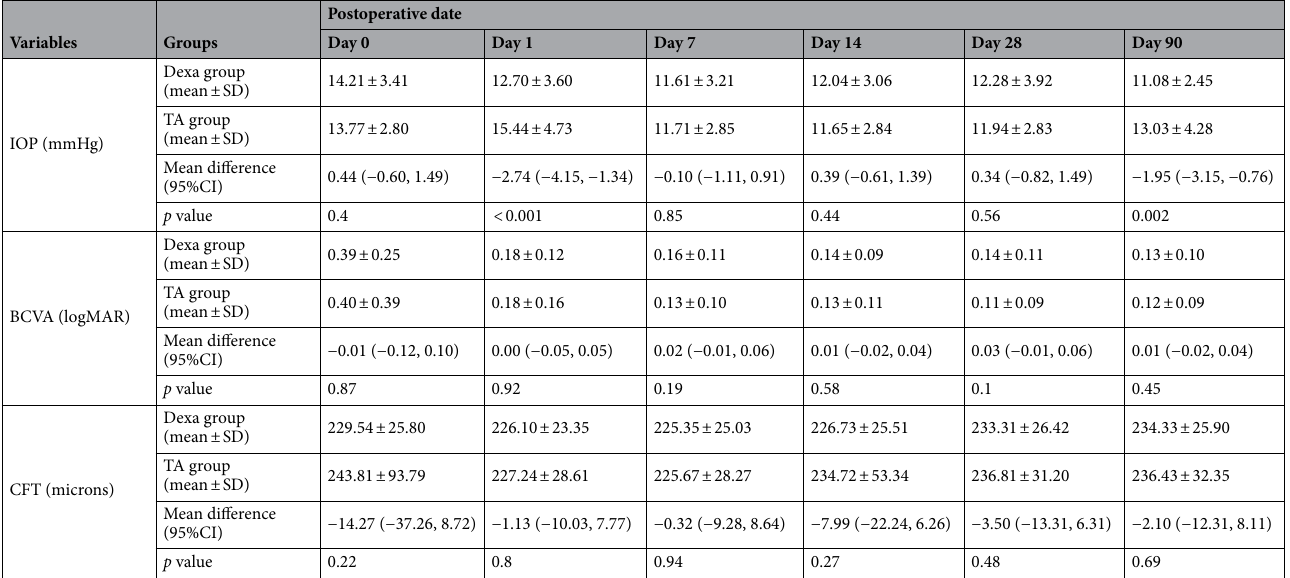
Table 3. Intraocular pressure (IOP), best-corrected visual acuity (BCVA), and central foveal thickness (CFT) at each study visit. IOP = intraocular pressure, BCVA = best-corrected visual acuity, CFT = central foveal thickness. logMAR = logarithm of the minimum angle of resolution; SD = Standard Deviation; CI = Confidence Interval. Dexa group = 0.1% dexamethasone eye drop group; TA group = subtenon 20-mg triamcinolone injection